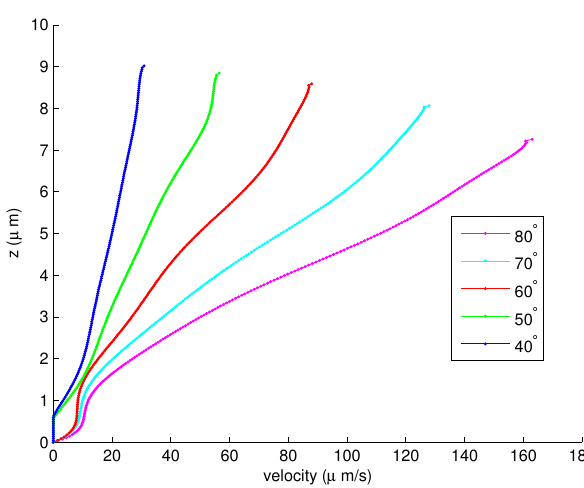
Figure 7. The velocities of the PCL fluid for the angles θ = 80 ◦ to θ = 40 ◦ .